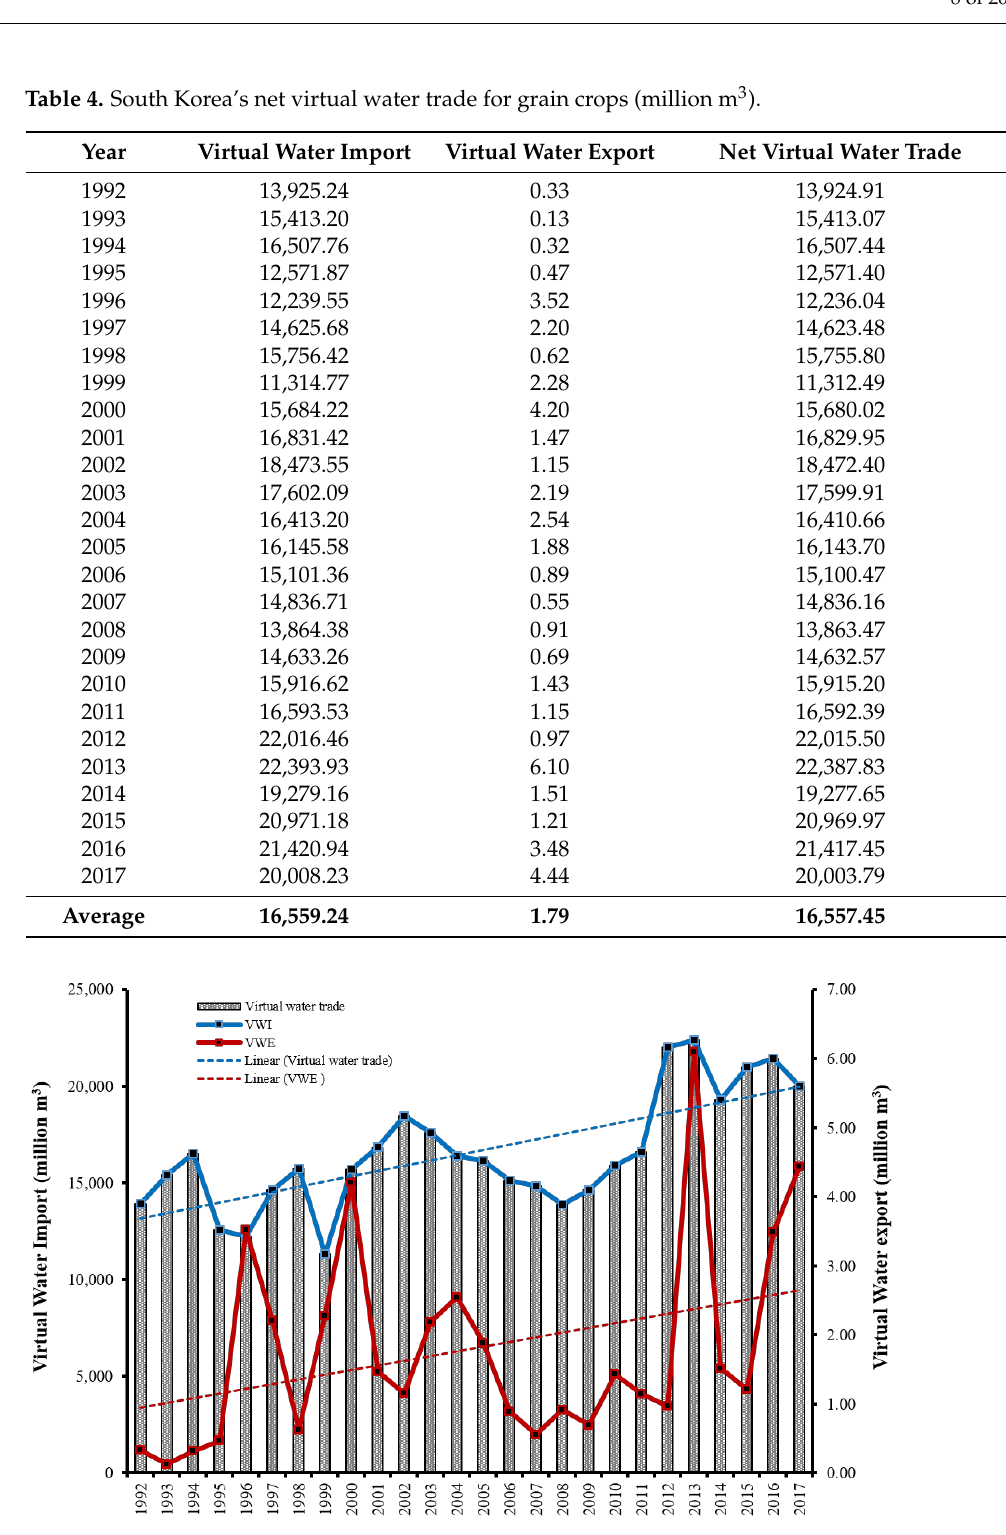
Figure 2. Net volume of the virtual water trade of grains in South Korea.